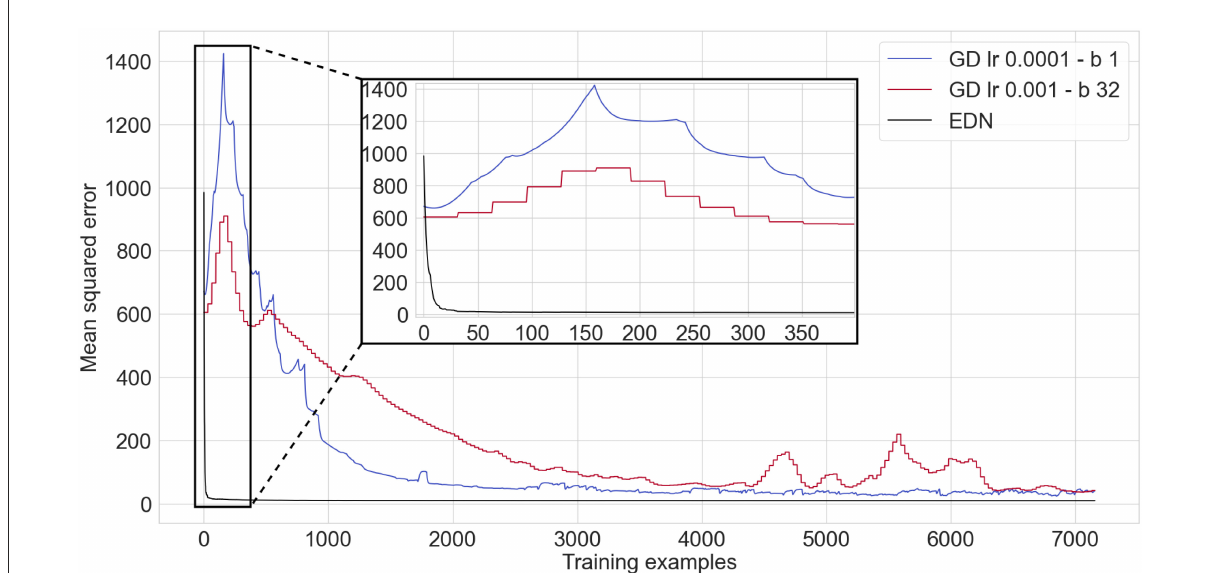
FIGURE6 A comparison of an ANN trained via gradient descent using ADAM optimization (red and blue, with lr being the learning rate and b being the batch size) against EDN (black) applied to the auto-mpg non-linear regression task. A zoomed in inset is given to display the learning curve of EDN. Batch sizes and learning rates were chosen which gave the fastest convergence in gradient